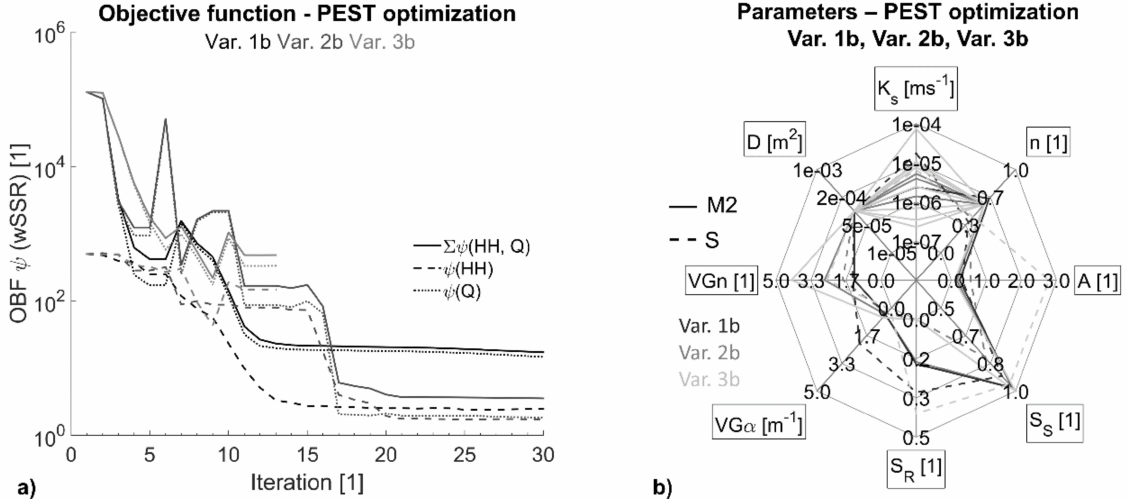
Figure 8. ( a ) PEST OBF minimization for Var. 1b–3b; ( b ) estimated parameters for Var. 1b–3b.